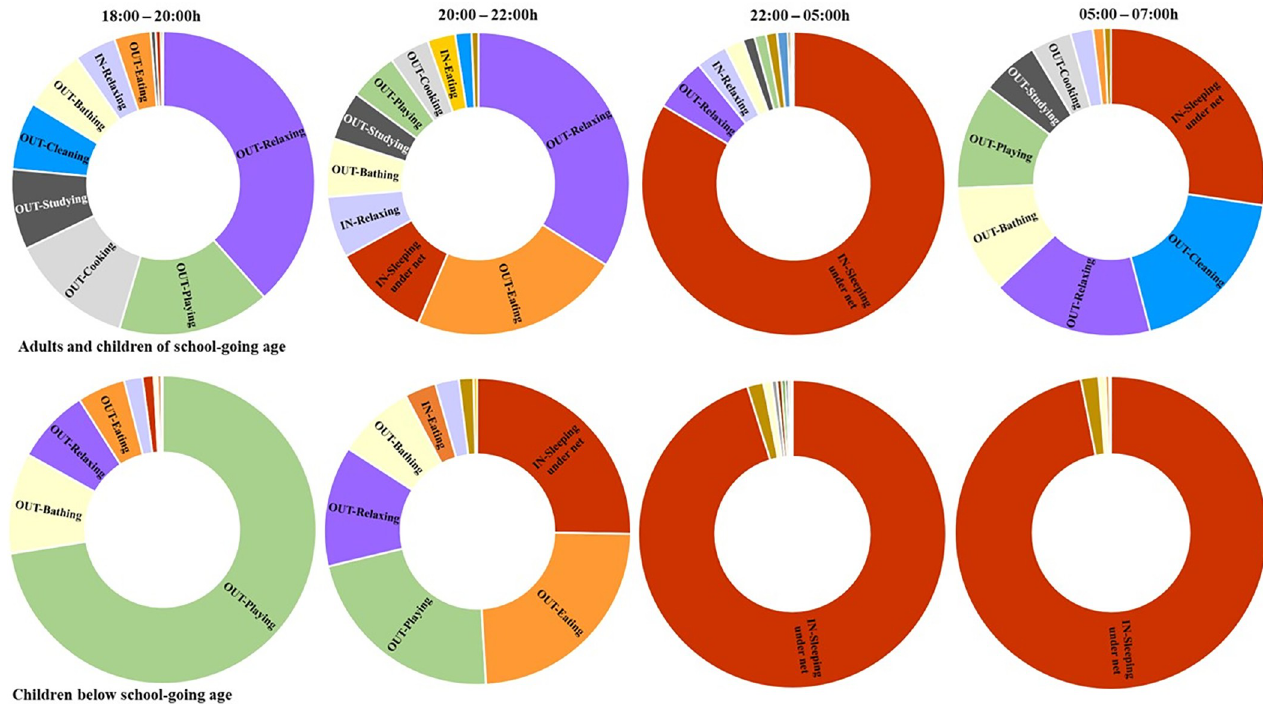
Fig 5. Indoor and outdoor activities observed among household members in the peri-domestic areas: a) Adults and children of school-going age, i.e. all household members of six years and above; (b) Children below school-going age, i.e. all household members of below six years.